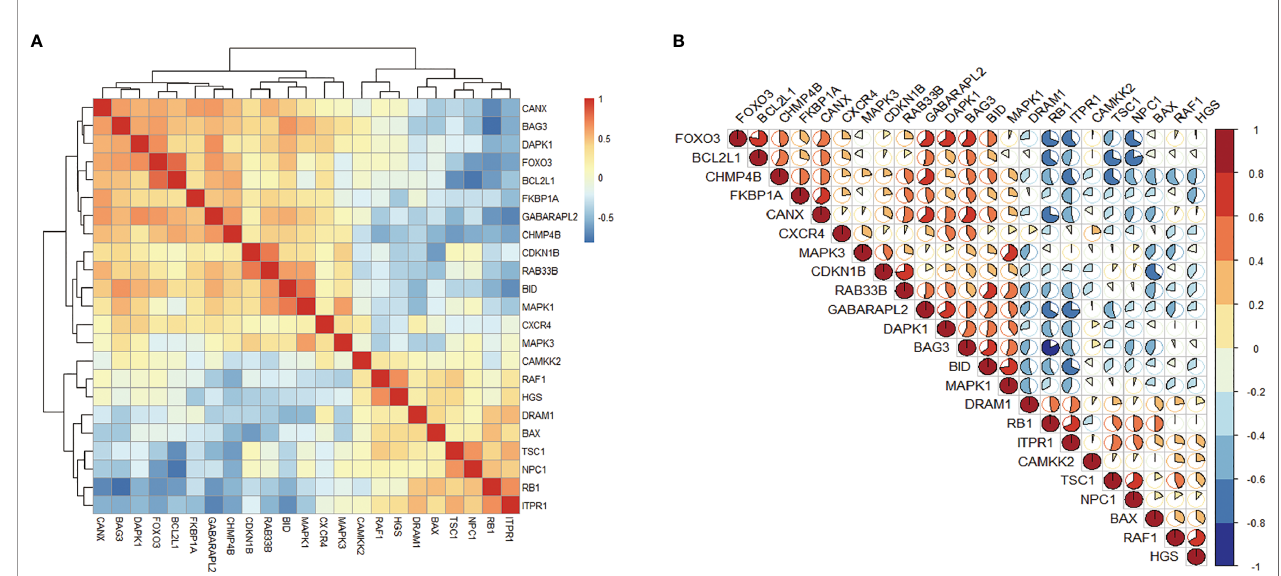
FIGURE 3 | Correlation analysis of 23 differentially expressed autophagy-related genes. (A, B) , Correlation heatmap.